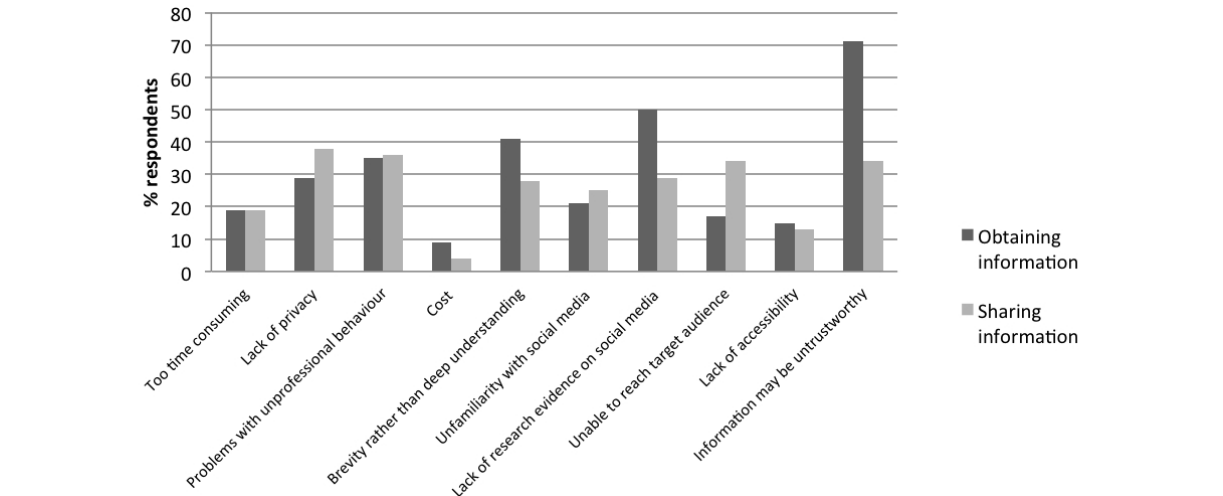
Figure 2. Obstacles to obtaining or sharing research or clinical information nominated by